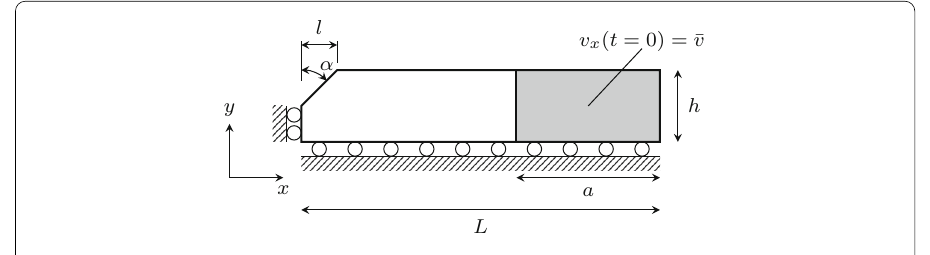
Fig. 15 One quarter of a double notched specimen, submitted to an initial tensile velocity on its right part